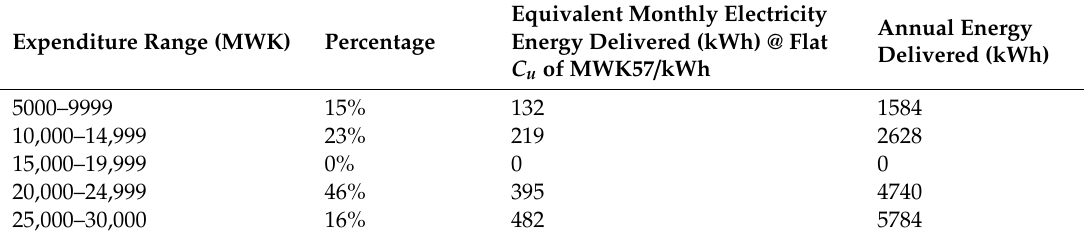
Table 3. Household expenditure on electricity. As of February 2020, $1 is equivalent to MWK